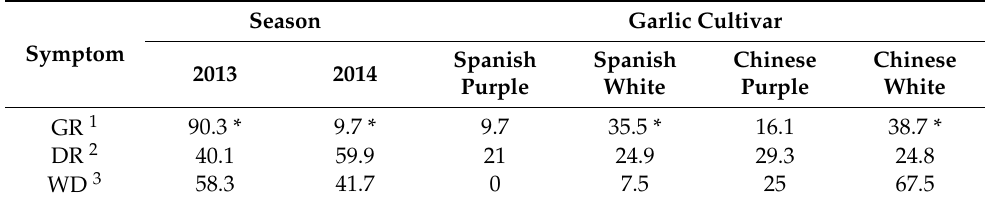
Table 2. Percentages of symptomatic cloves (incidence means) depending on the harvest season and cultivar according to logistic regression